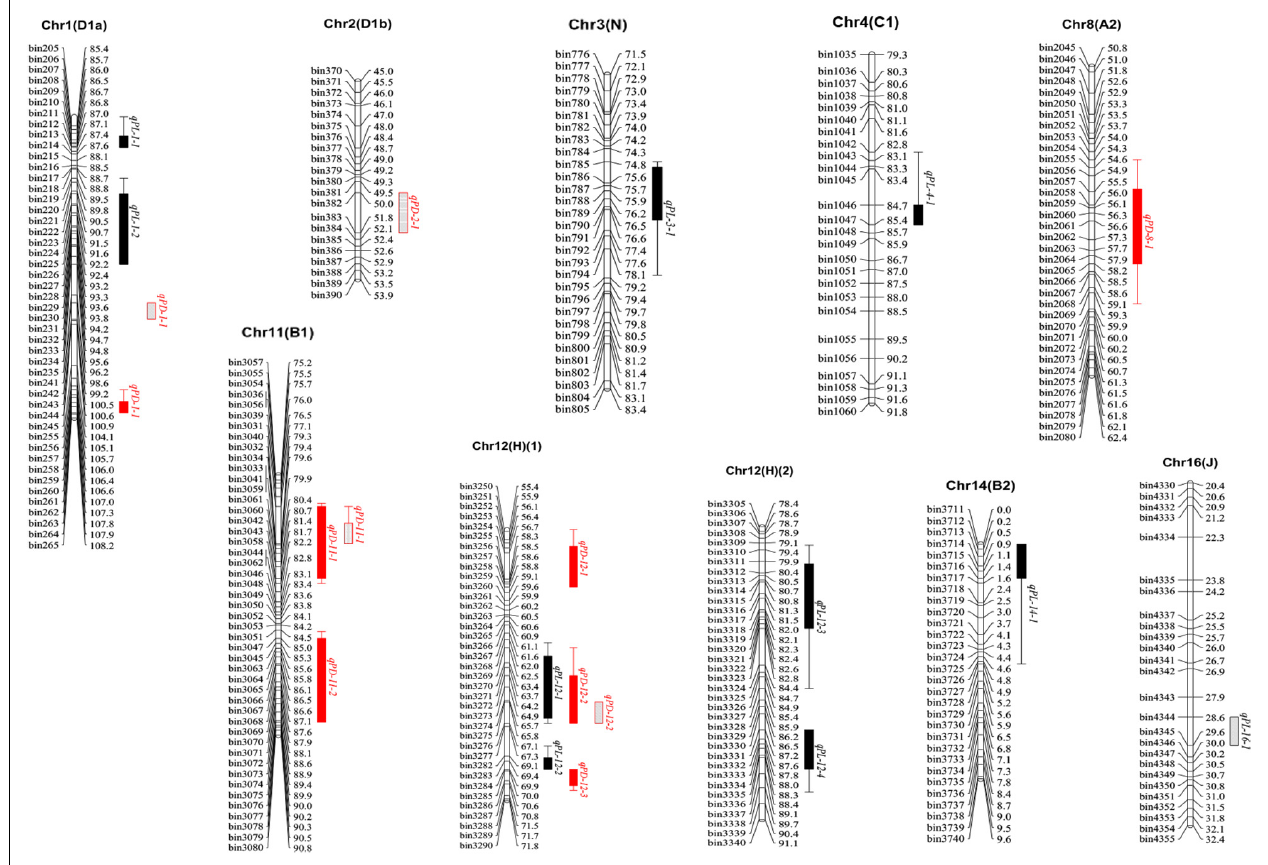
FIGURE 2 | Locations of QTLs on genetic linkage map for pubescence length (PL) and pubescence density (PD). Black graphics represent the QTLs were responsible for PL. Red graphics represent the QTL were responsible for PD, and the filled graphics represent QTLs detected by the CIM method, while the hollow graphics represent QTLs detected by the MCIM method (Due to the high-density markers, this figure only shows the region where the QTL is located, the complete map is shown in Supplementary Figure 2 ). QTL, quantitative trait loci; CIM, composite interval mapping; MCIM, mixed model-based composite interval